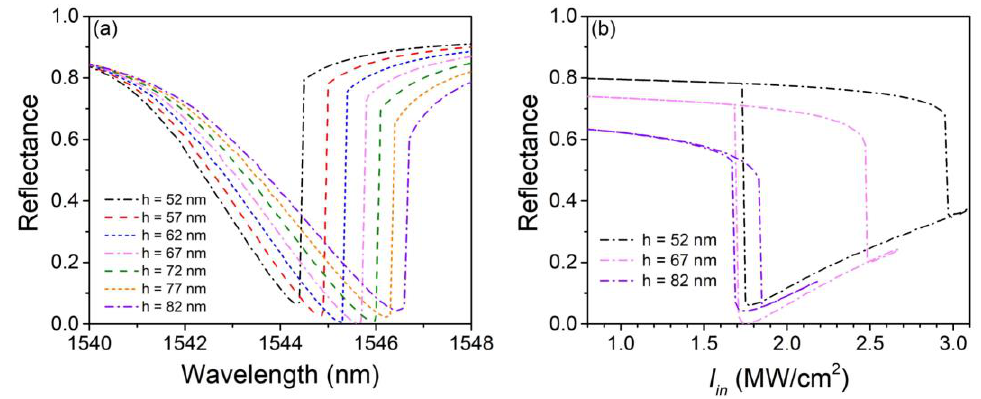
Figure 5. ( a ) Nonlinear reflectance spectrums with different grating thicknesses h . ( b ) Hysteresis loops with h = 52, 67, and 82 nm, respectively.